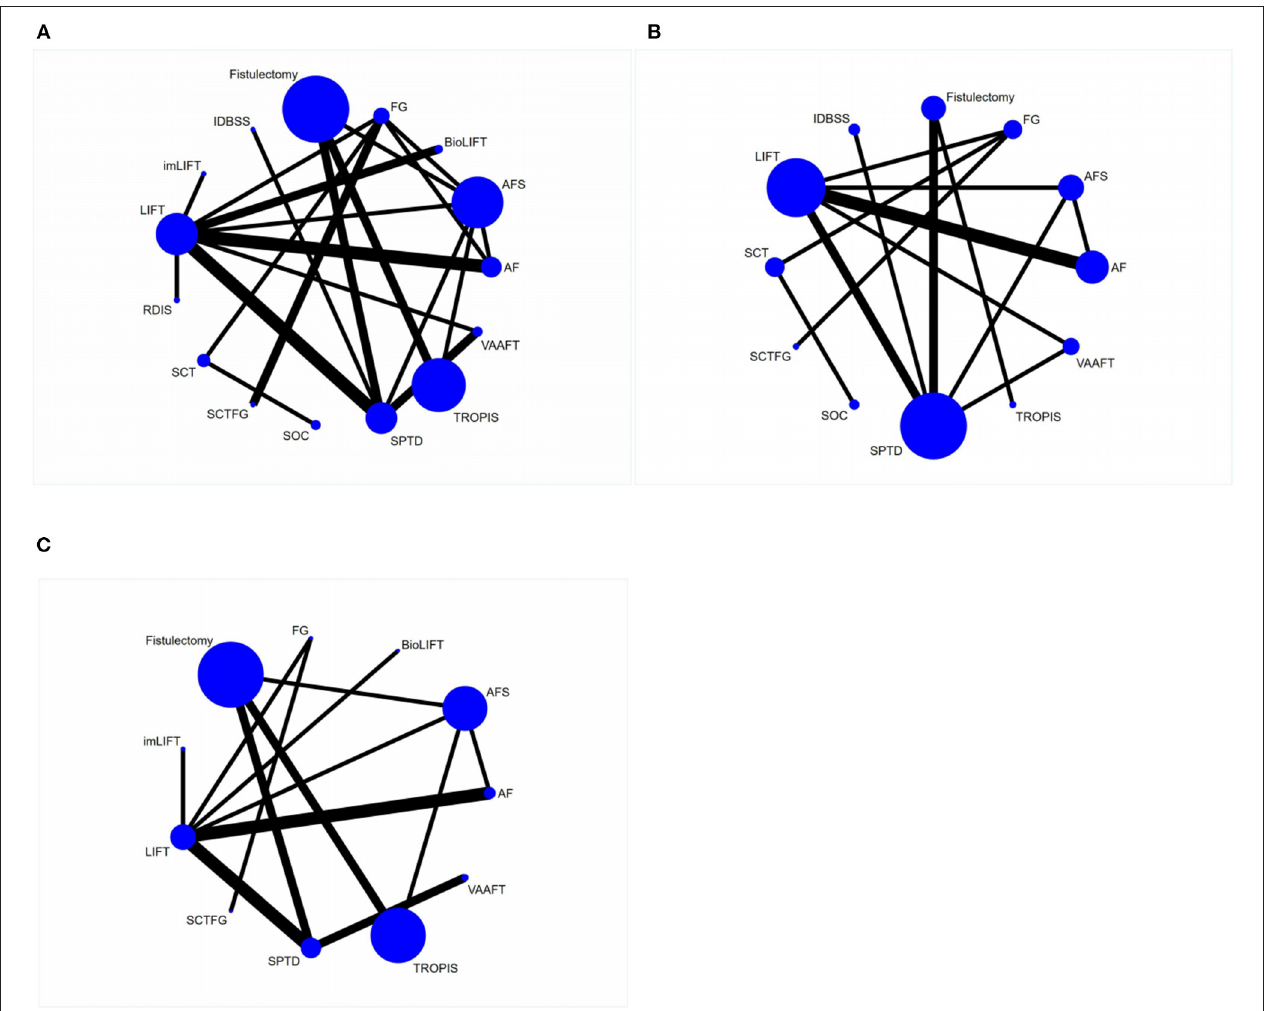
FIGURE 2 | Reticulated evidence diagram of different sphincter-preserving surgeries. (A) Network evidence for cure rate; (B) Network evidence for recurrence rate; (C) Network evidence for complication rate.